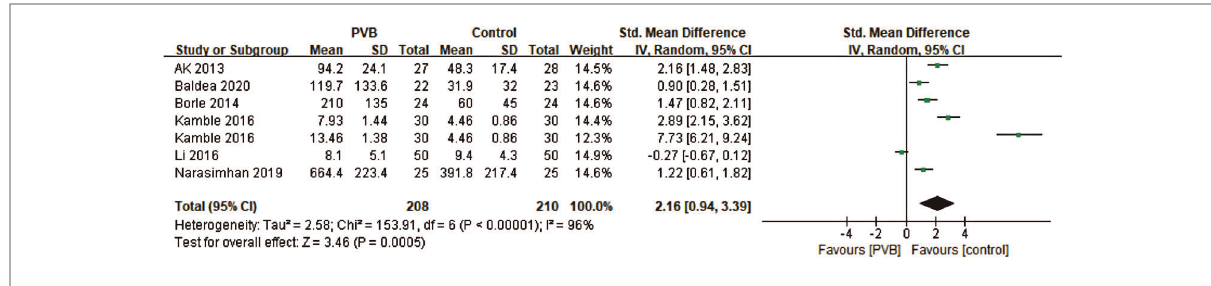
FIGURE 6 Forest plot of time to fi rst postoperative analgesic requirement.